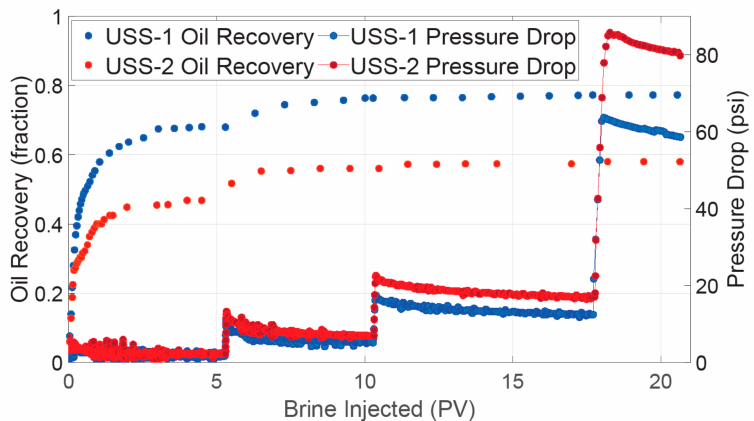
Figure 4. Comparison between USS-1 and USS-2.